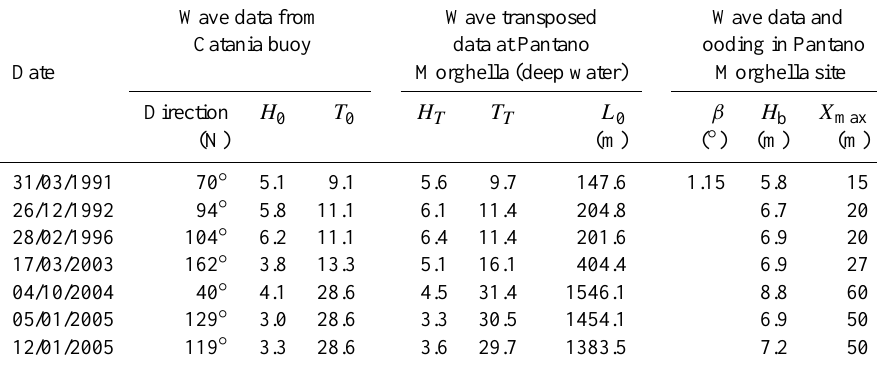
Table 1. Storm events with maximum wave height ( H 0 ) and peak period ( T 0 ) in deep water recorded by the Catania buoy and transposed data for Pantano Morghella site ( H T and T T )